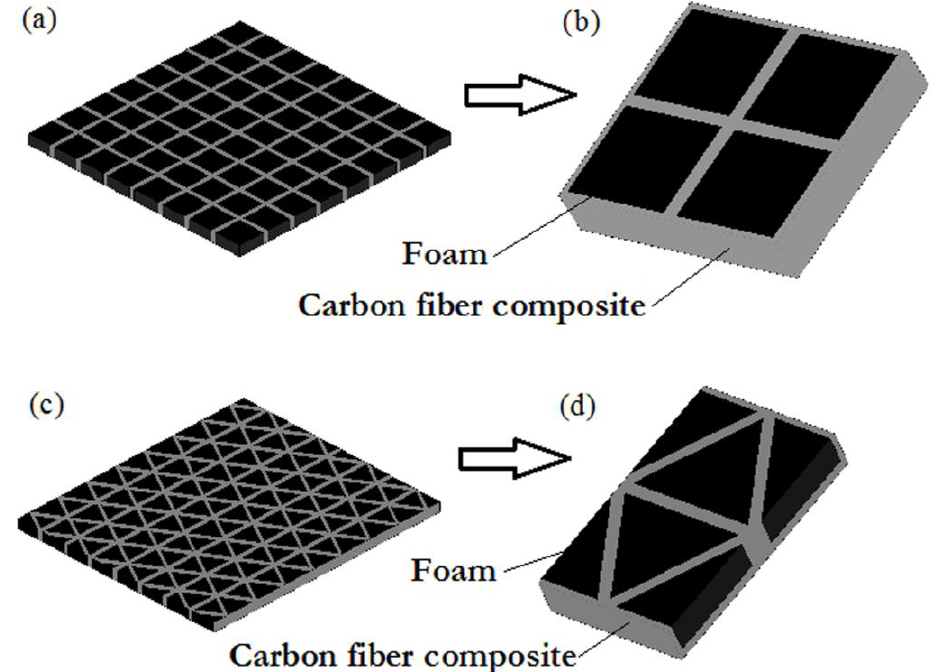
Figure 6. Models of carbon-fiber lattice panels filled with foam absorber: ( a ) rectangular panel, ( b ) rectangular panel model, ( c ) equilateral panel and ( d ) equilateral panel model.